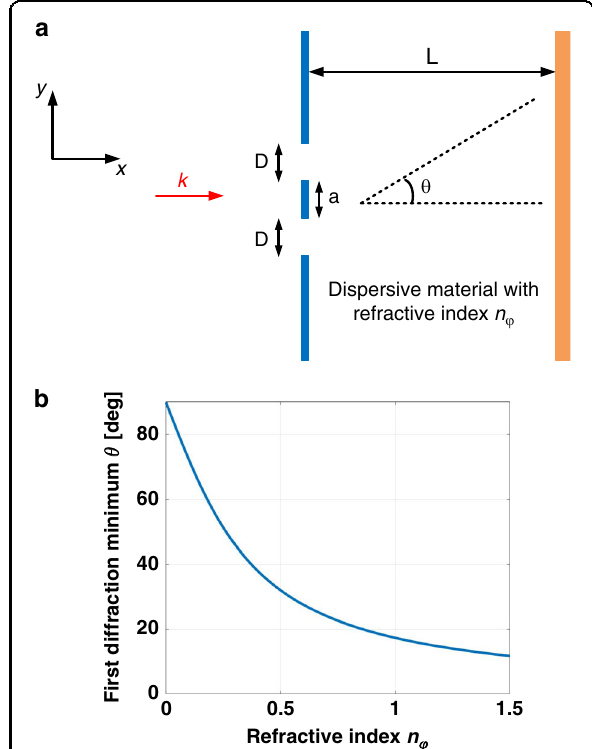
Fig. 3 Young double-slit experiment within dispersive material. a EM wave with k wavevector is sent on a double-slit with slit width D at a distance L from an observing screen. The distance between the slits is a . b First diffraction minimum as a function of refractive index. Wavelength is set to 500 nm for a separation width of a = 800